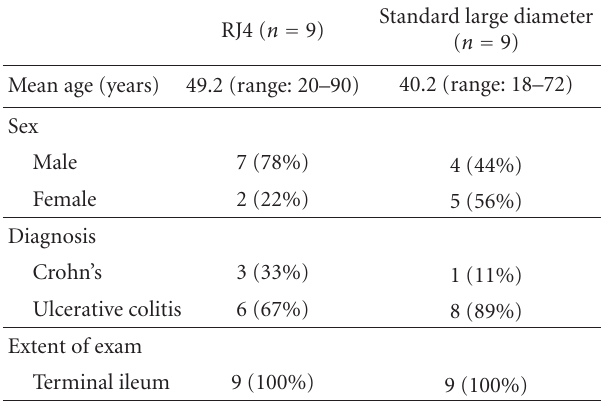
Table 1: Clinical and demographic characteristics of inflammatory bowel disease patients.